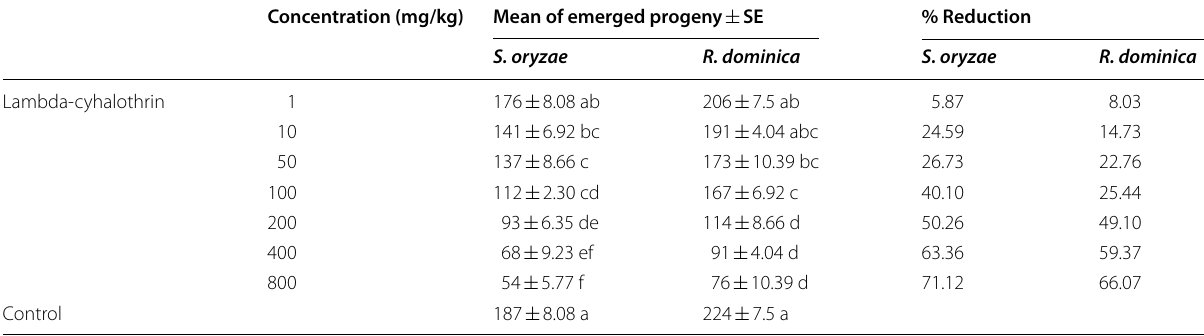
In the same column, means followed by the same letters are not significantly different at 0.05 level according to Duncan multiple range test